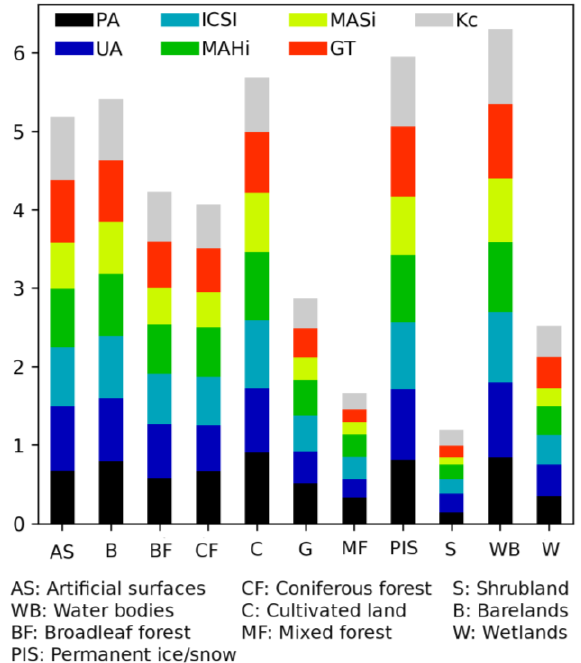
Figure 2. GL30-11 analysis results: values of per-class indexes (producer’s accuracy PA ; user’s accuracy UA ; Individual Classification Success Index ICSI ; Hellden’s mean accuracy MAHi ; Short’s mean accuracy MASi ; Ground Truth GT ; Conditional Kappa Kc